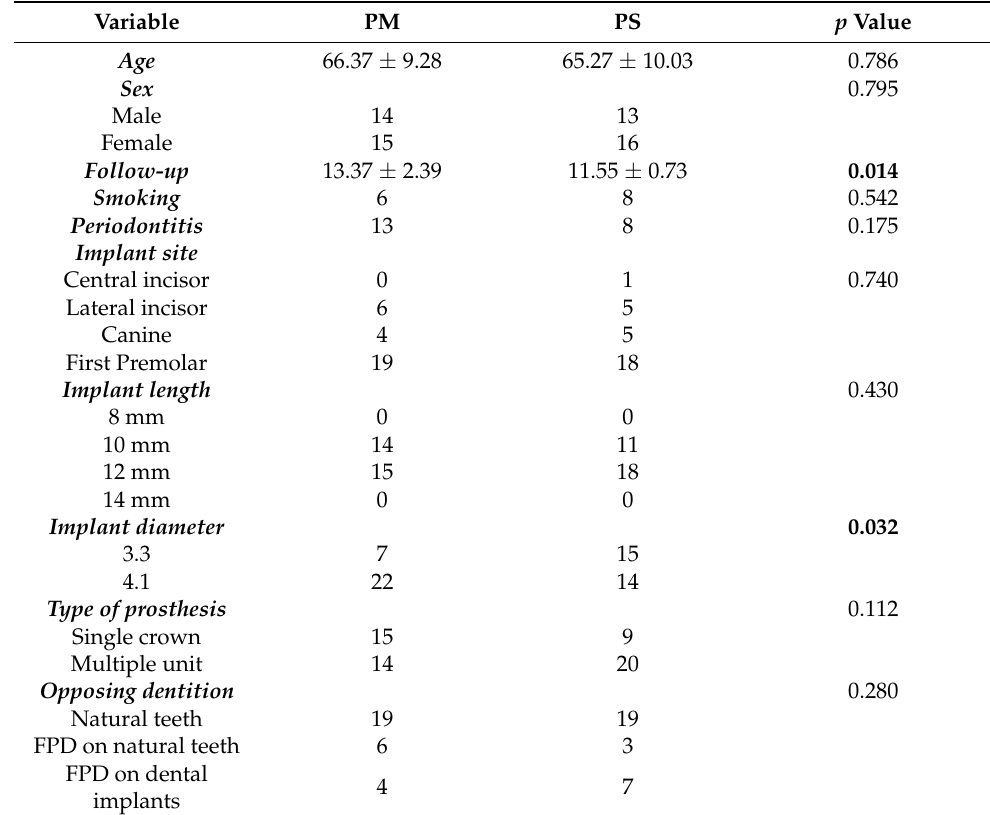
Table 1. Sample demographics.